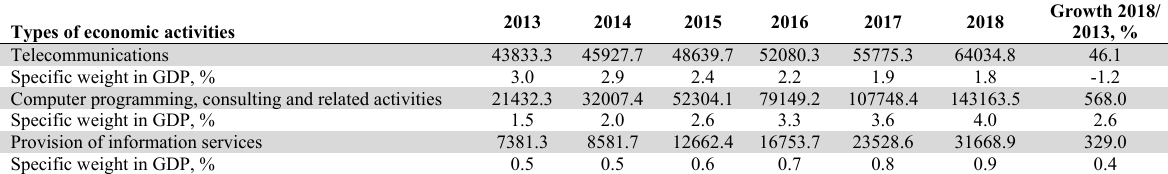
Dynamics of production volumes of products (services) of the main types of economic activities in the field of digital trans- formation of the economy in Ukraine Types of economic activities